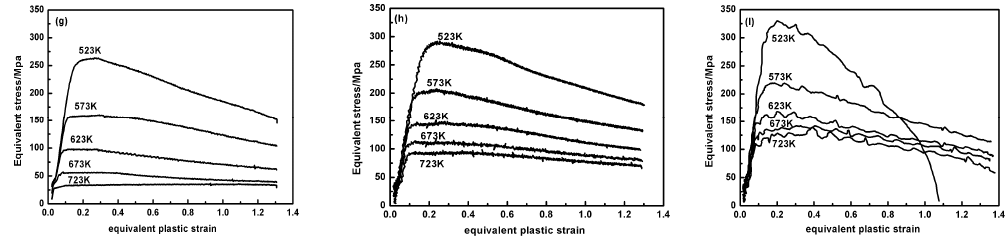
Figure 2. Flow stress vs. strain curves for 7050 aluminum alloy at hot tensile (HT) mode: ( a ) 0.01 s − 1 ;